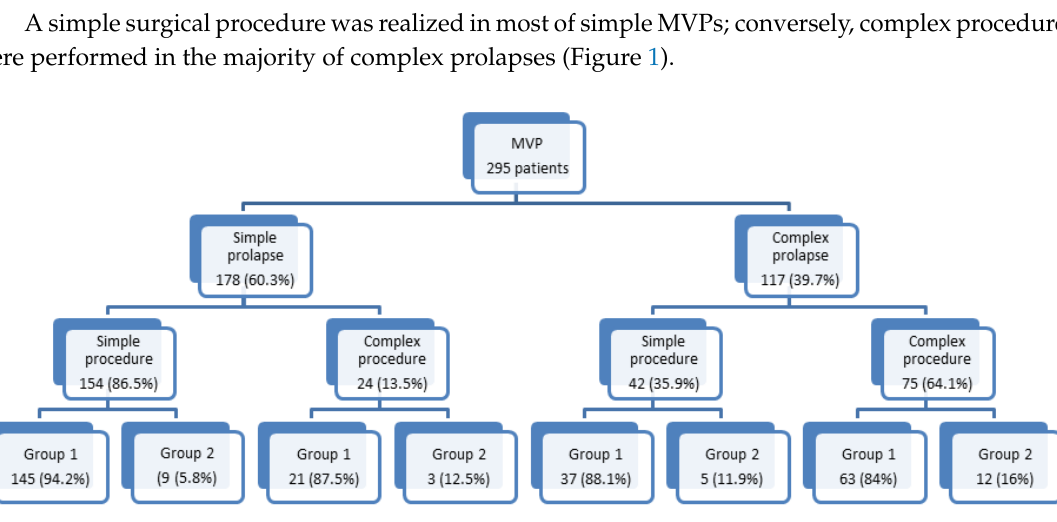
Figure 1. Flow-chart scheme showing the number and percentage of cases with simple vs. complex mitral valve lesions, types of cardiac surgery according to complexity of mitral lesions and 6 month residual mitral valve regurgitation ≤2 (Group1) or >2 (Group 2). MVP = mitral valve prolapse. Baseline, 6M and 3Y 2DTTE parameters are summarized in Table 3. Table 3. Mean ±SD for 2D transthoracic echocardiographic parameters at baseline and at 6 months and 3 years follow-up. Basal